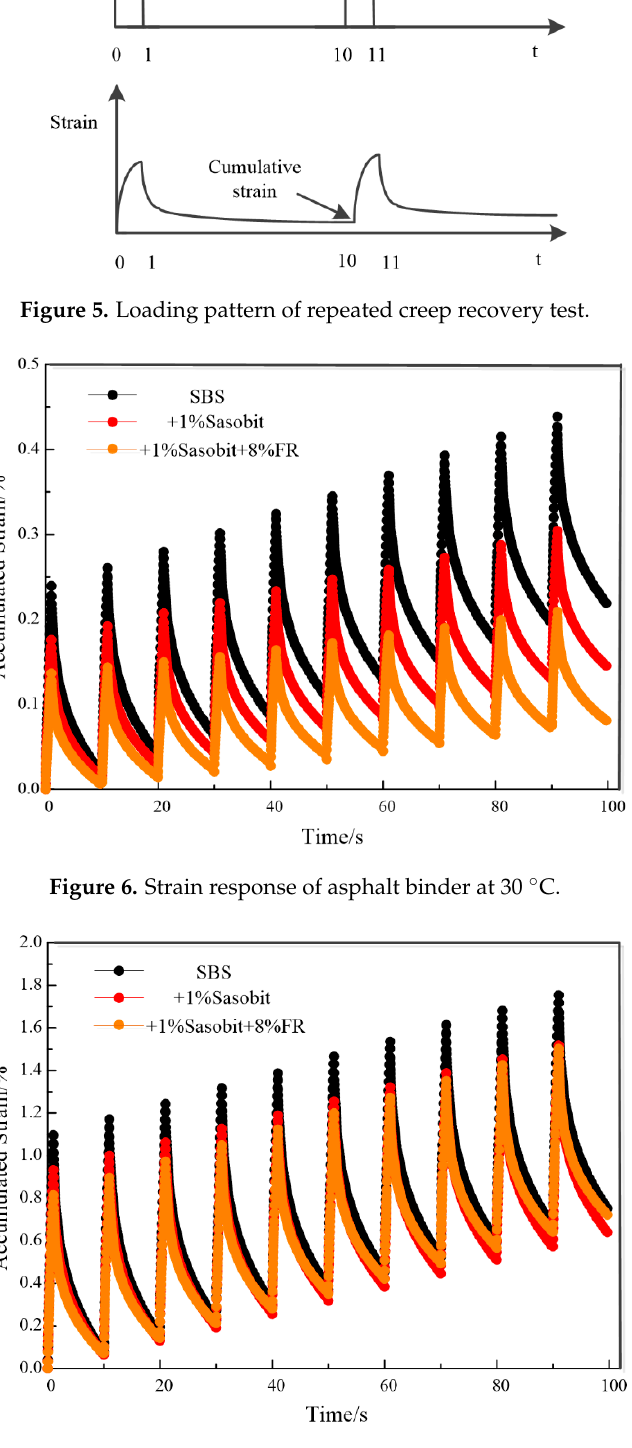
Figure 7. Strain response of asphalt binder at 40 °C.